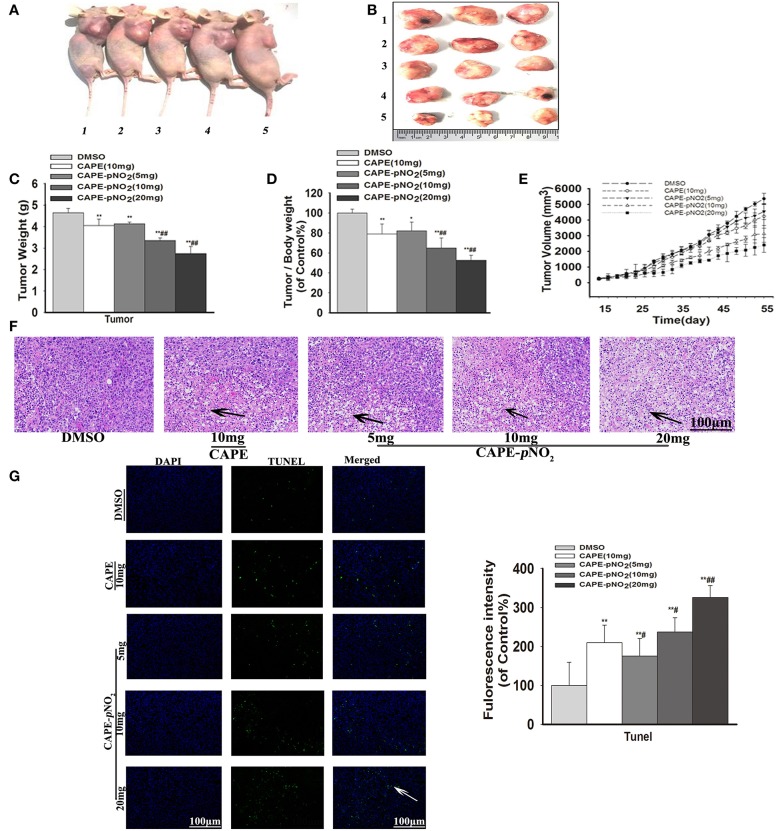
Antitumor activity of CAPE-pNO2 in xenograft tumors. Xenograft mice were treated with either DMSO (2%) (vehicle group), CAPE (10 mg/kg/day) or CAPE-pNO2 (5, 10, and 20 mg/kg/day) for 38 days. (A) Images of euthanized mice. Groups 1, 2, 3, 4, and 5 represented the DMSO (2%) group, the CAPE (10 mg/kg/day) group and the CAPE-pNO2 groups (5, 10, and 20 mg/kg/day), respectively. (B) Images of excised tumors. (C) Xenograft breast tumor weights. (D) Tumor/body weights. (E) The progression of xenograft breast tumor volume from different experimental groups. (F) HE staining of tumor sections (Black arrows indicate the necrotic area). (G) TUNEL staining of tumors (White arrows points to apoptotic cancer cells). The bar graph shows the fluorescence intensity statistics analyzed by Image-Pro Plus software. Values represent the mean ± SD from three independent experiments; *p < 0.05, **p < 0.01: CAPE and CAPE-pNO2 compared with DMSO group; #p < 0.05, ##p < 0.01: CAPE-pNO2 (5, 10 and 20 mg/kg) compared with CAPE (10 mg/kg).